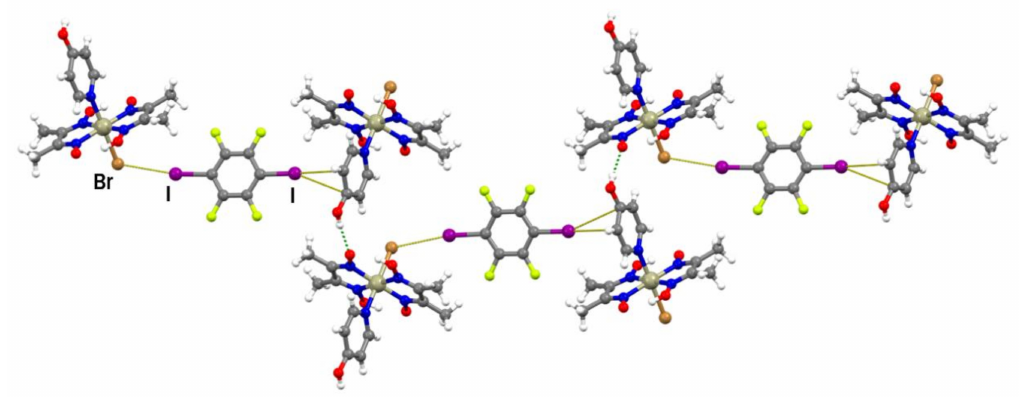
Figure 5. Halogen-bonded units of ( III ) 2 ( 14tfib ) connected by O–H ··· O hydrogen bonds into a chain.